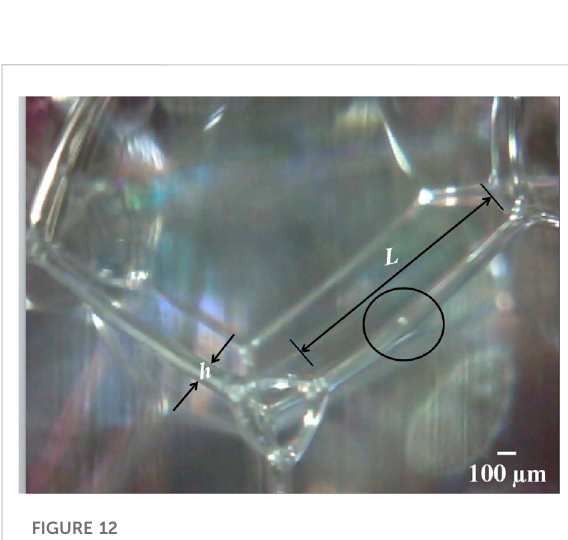
FIGURE 12 High-resolution photograph of the Plateau borders for a foamproducedinPipe2withtopclosed.Onaverage,thediameter of the Plateau borders is from h =100 – 120 μ m. The black circle encloses a polyamide tracer particle fl owing through a Plataeu border of length L as was observed with a microscope resolution corresponding to a magni fi cation of ×